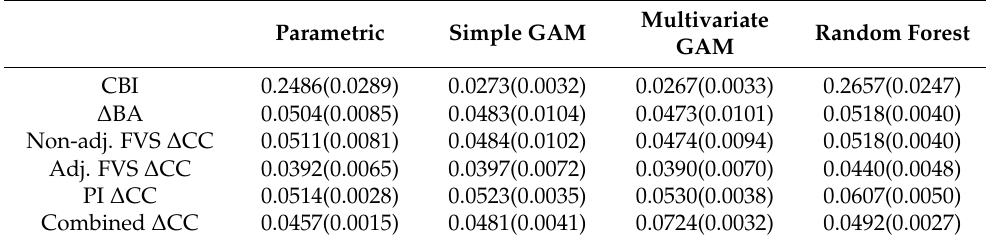
Table A3. Comparison of test MSE (and standard deviation of test MSE in parentheses) averaged across 7 folds for each model form (parametric (Equations (1)–(3)), simple GAM, multivariate GAM, and Random Forest) using EA Landsat RdNBR with offset as a predictor.